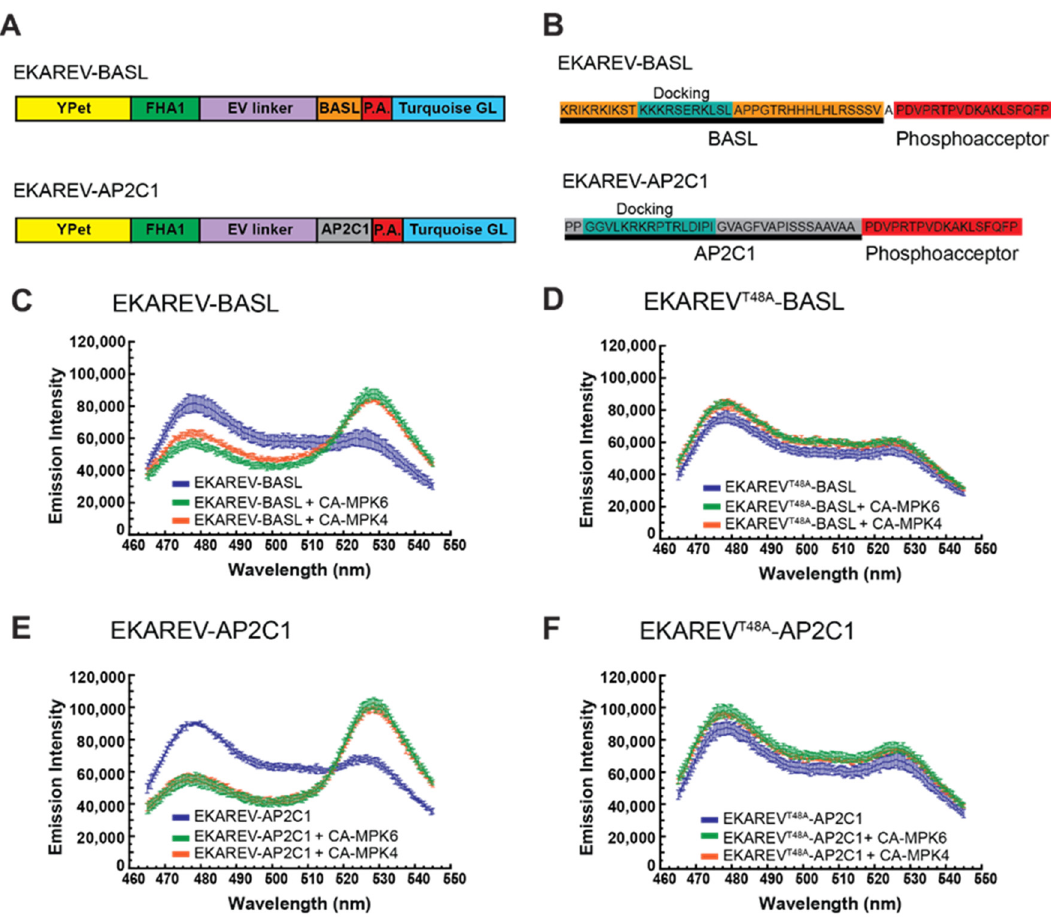
Figure 2. Inserting plant MAPK docking domains into EKAREV allows for large MAPK-induced increases in FRET. ( A ) Domain structure of EKAREV-BASL and EKAREV-AP2C1. YPet is a yellow fluorescent protein, FHA is the FHA1 phosphopeptide binding domain of yeast RAD53, EV linker is a flexible linker domain, P.A. is the phosphoacceptor region of the mammalian CdC25C protein, BASL is a 39 aa region of the plant BASL protein that contains a plant MAPK docking domain. AP2C1 is a 35 a region of the AP2C1 protein that contains a plant MAPK docking domain. Maps are not to scale. ( B ) Protein sequence for the docking domain and phosphoacceptor regions of each biosensor. Sequence from the BASL protein is highlighted in orange, sequence from the AP2C1 protein is highlighted in grey, and the EKAREV phosphoacceptor domain is highlighted in red. The docking domains are highlighted in blue-green. ( C – F ), Data from in vitro FRET assays using EKAREV-BASL ( C ), EKAREV T48A -BASL ( D ), EKAREV-AP2C1 ( E ), or EKAREV T48A -AP2C1 ( F ) in the presence or absence of constitutively active MPK6 (CA-MPK6) or MPK4 (CA-MPK4). The emission spectra in response to excitation at 435 nm is shown. The values plotted are the means of three technical replicates of each experiment, with the error bars indicating standard deviation. Emission intensity units are arbitrary “counts per